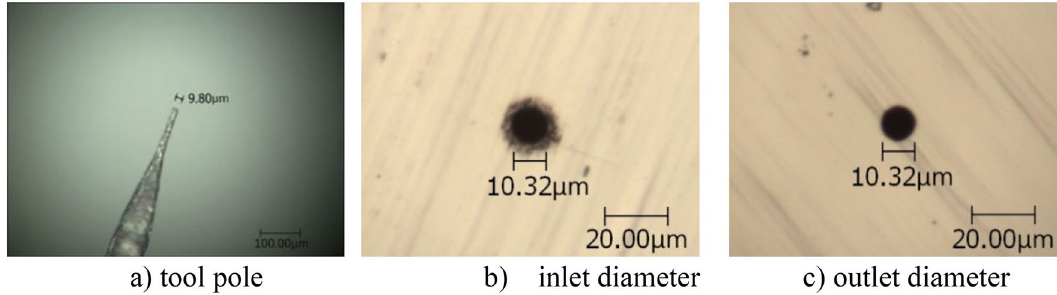
Figure 1. Micro holes produced at k 1 = 0.92 and k 2 = 0.